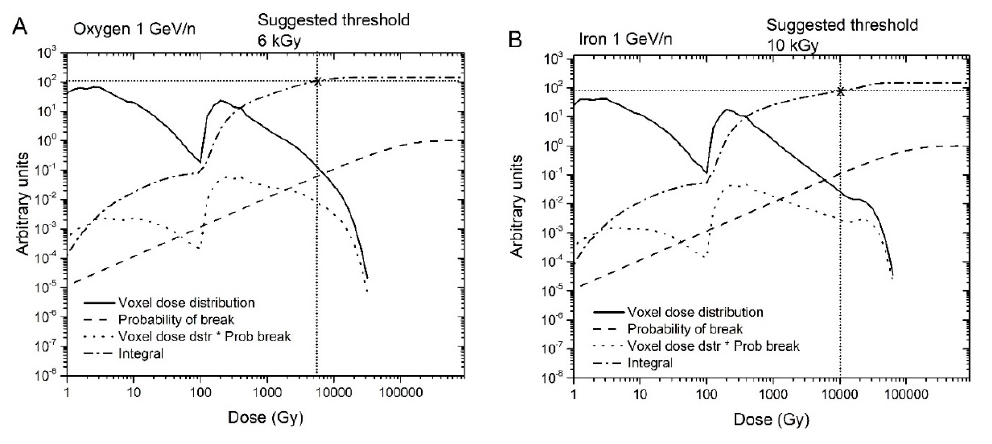
Figure 4. Dose distribution per voxel, probability of at least one break, voxel dose distribution x probability of at least one break, and cumulative integral of the previous quantity for oxygen 1 GeV/n ( A ) and iron 1 GeV/n ( B ). VI.